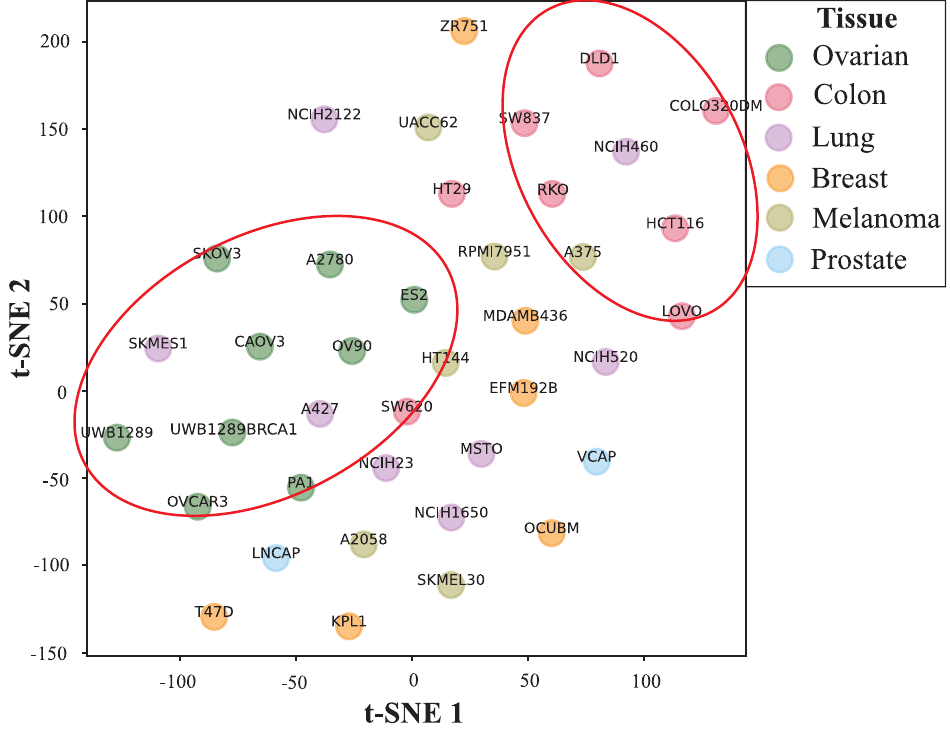
Fig 3. Visualization of drug Zolinza cell line-specific embeddings in 2-dimensional space using t-SNE.